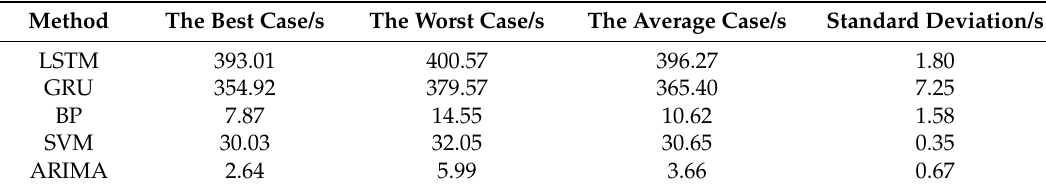
Table 4. The training time of each